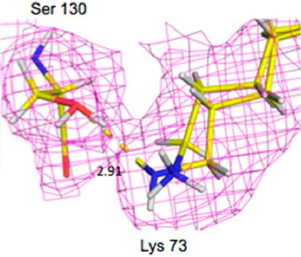
Figure 13. Proposed catalytic residues Lys73 in class A—lactamase could act as a general base. In the acyl-enzyme complex, Lys73 can be modeled in two conformations. The nuclear density map is shown in pink mesh and is contoured at 0.8 σ . Reprinted (adapted) with permission from [45]. Copyright 2016 American Chemical Society.